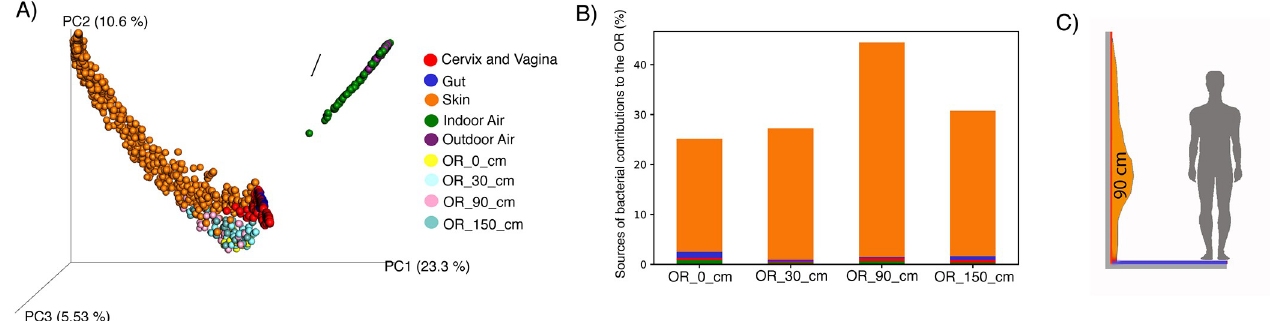
Fig 6. Source-tracking analyses. Panel A shows the PCoA with OR samples compared to other samples of the public repositories, including the cervix and vagina, gut, skin, and indoor and outdoor air. The bar plots of panel B show the relative contributions from the different sources for each sampled distance. Panel C summarizes the sampling conducted and shows higher abundances of skin microbes at